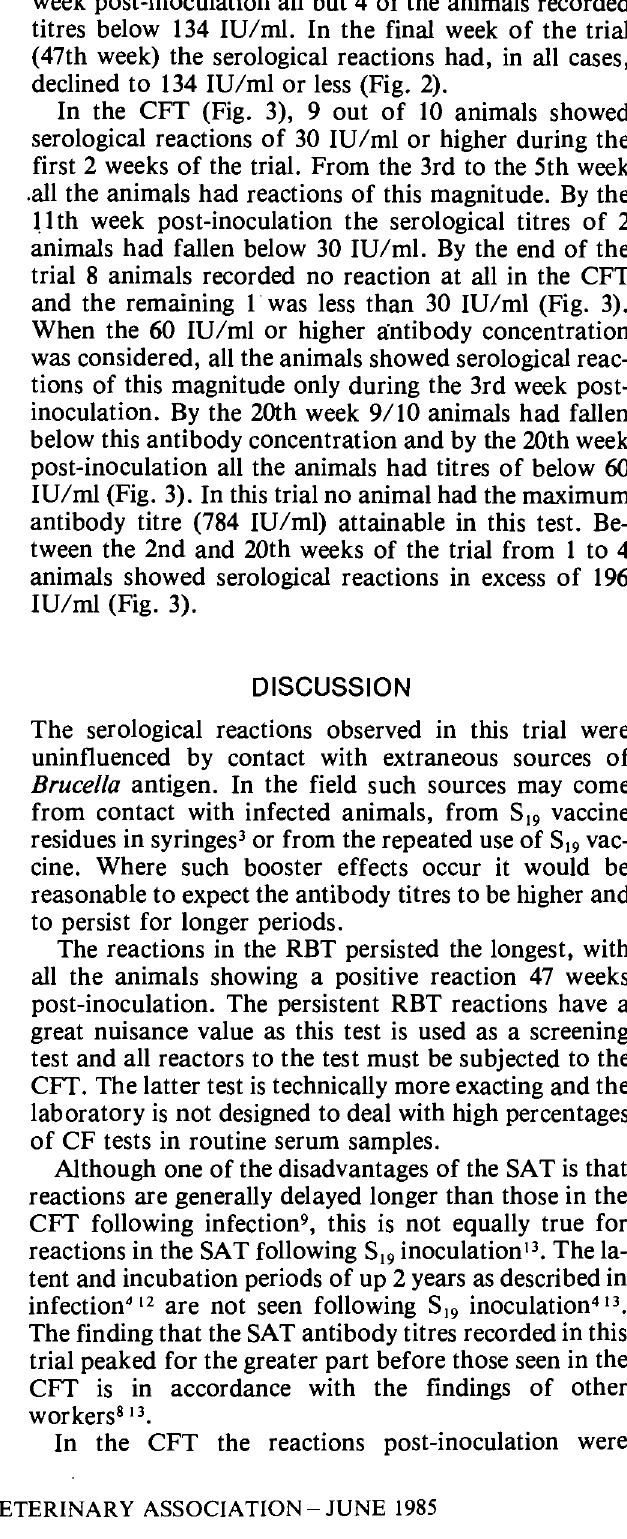
Fig. 3: The distribution of serological titres in the eFT after in· oculation with 5 19• *Numerals indicate number of animals reacting at the an· tibody concentration expressed in IU/ml; vertical bars represent the range * *60 IU/ml or higher represents a positive reaction in adult in· oculated animals ***30 IU/ml or higher represents a positive reaction in all other